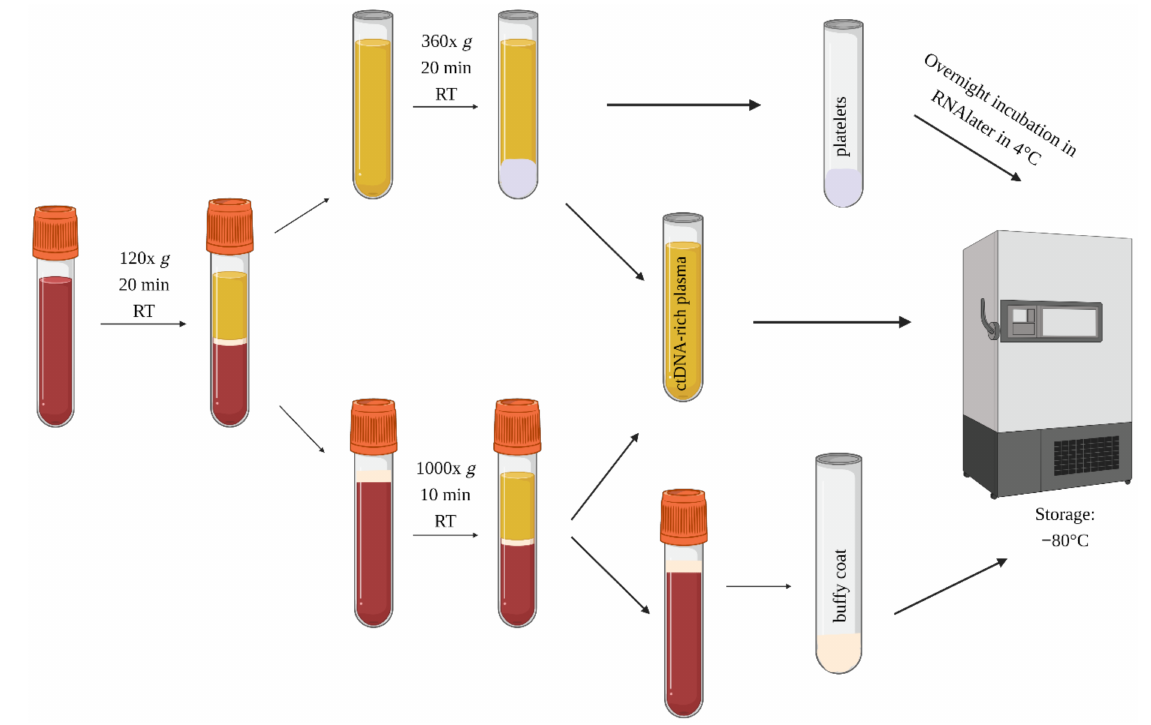
Figure 2. The blood processing protocol for the collection of platelets, ctDNA-rich plasma (somatic mutations), and buffy coat (germline